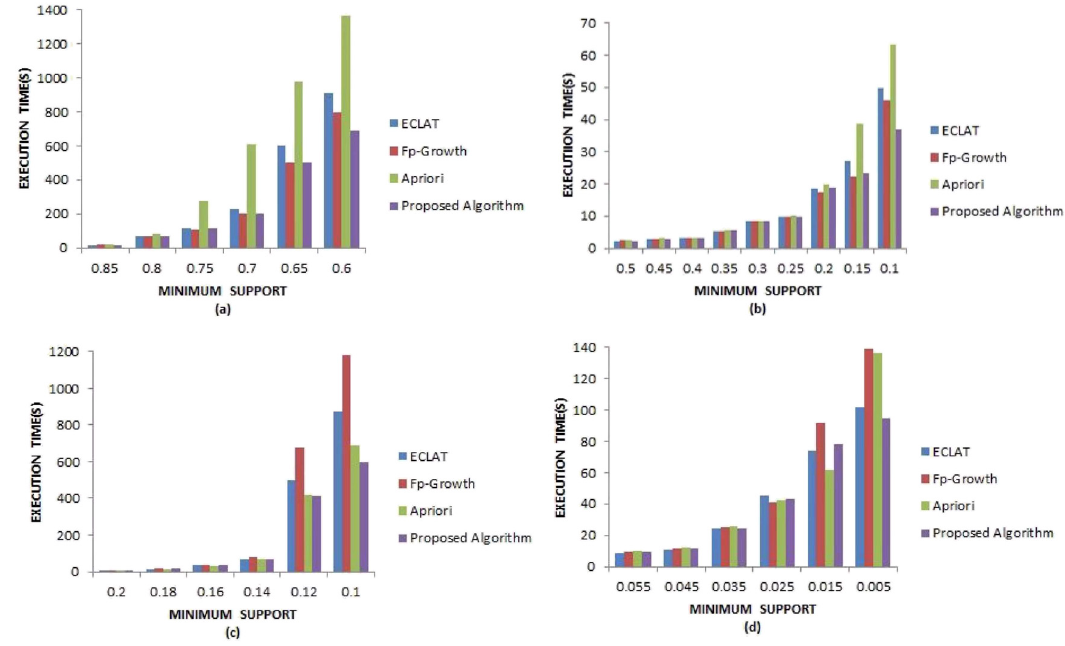
Figure 1: Execution time vs minimum support ( a ) using Chess dataset, ( b ) using Mushroom dataset, ( c ) using T I D K 40 10 100 dataset, and ( d ) using T I D K 10 4 100